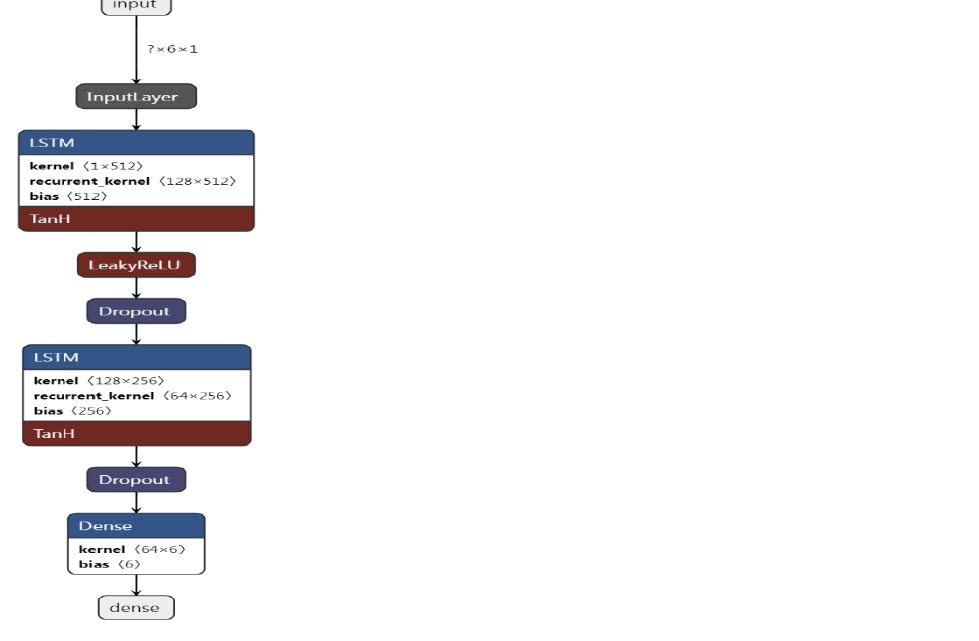
Figure 11. Bi-LSTM model architecture for blood glucose forecasting at 30 min prediction horizon with 6 samples per example and single feature. The size of input data is ‘?×6×1′ where ‘?’ represents the number of examples fed to the model.